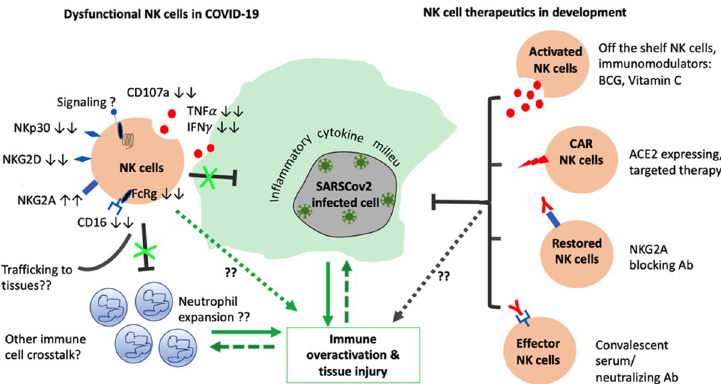
Fig 1. Potential roles of NK cells and NK cell–based interventions in COVID-19. FcRg, Fc receptor gamma chain; IFN γ , interferon-gamma; NK, natural killer; TNF α , tumor necrosis factor alpha. NK cells in COVID-19–infected people exhibit lower expression of activating receptors including NKp30, NKG2D, NKG2C, CD16, and Fc receptor γ chain (FcR γ ) and higher inhibitory NKG2A expression. As a consequence, NK cells exert reduced degranulation and cytokine secretion, which could interactions with other immune cells and contribute to overall hyperimmune activation and tissue injury. Several NK cell–based therapeutics currently in development against COVID-19 infection employ different strategies, including inducing NK cell activation, inhibiting NK exhaustion, and eliciting effector functions of NK cells against infected cells for early clearance of viral infected cells, and prevent tissue injury.